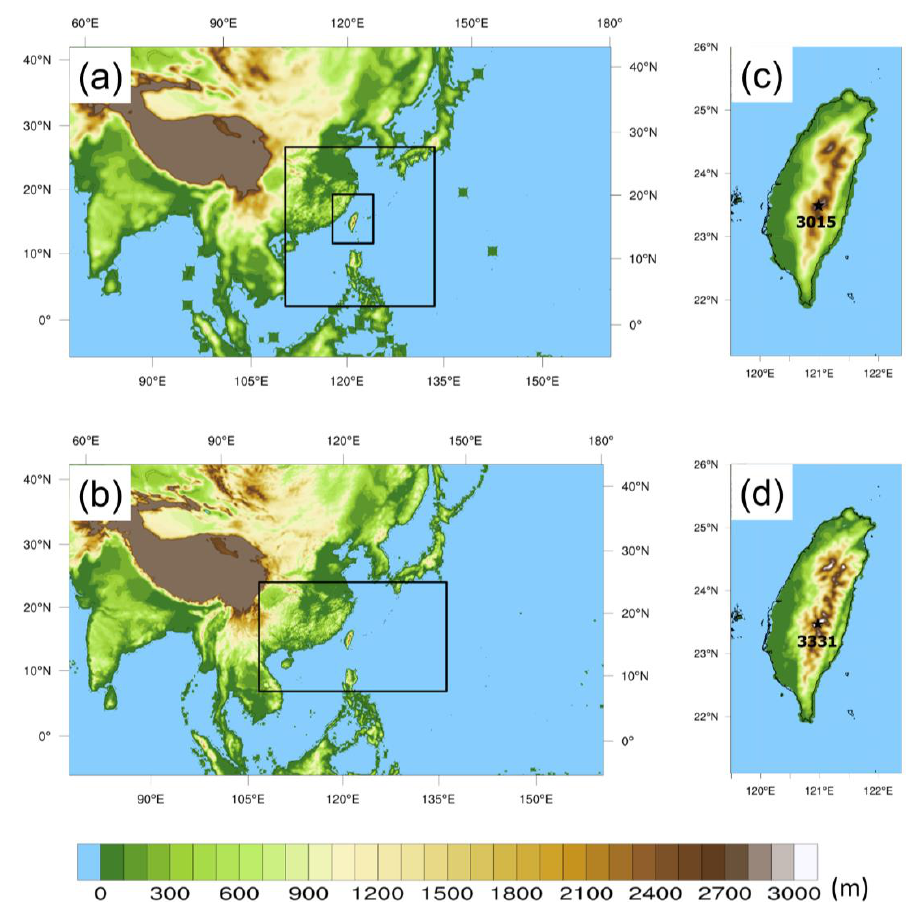
Table 1. The designation using different TWRF versions (V) and resolutions in each domain (D).